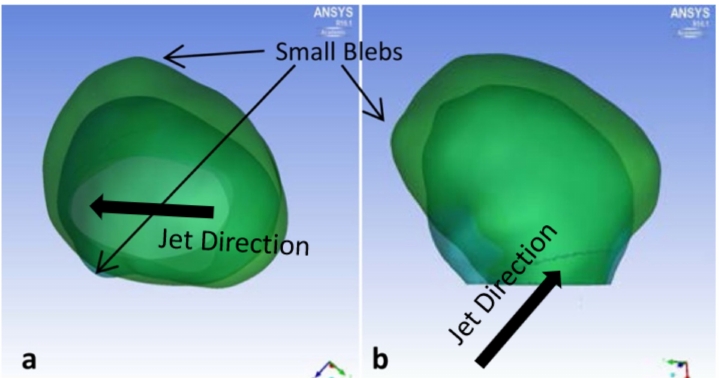
Figure 6. P3 aneurysm growth comparisons between initial diagnosis and follow-up times. ( a ) Top view and ( b ) side view, with block arrows indicating direction of impingement